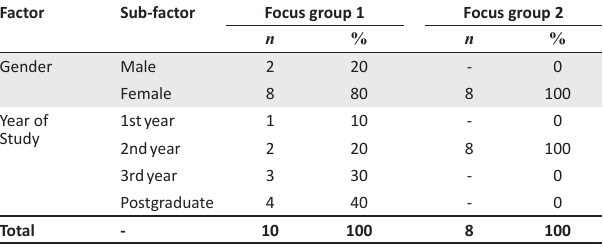
TABLE 1: The descriptive statistics for gender and year of study of the focus group